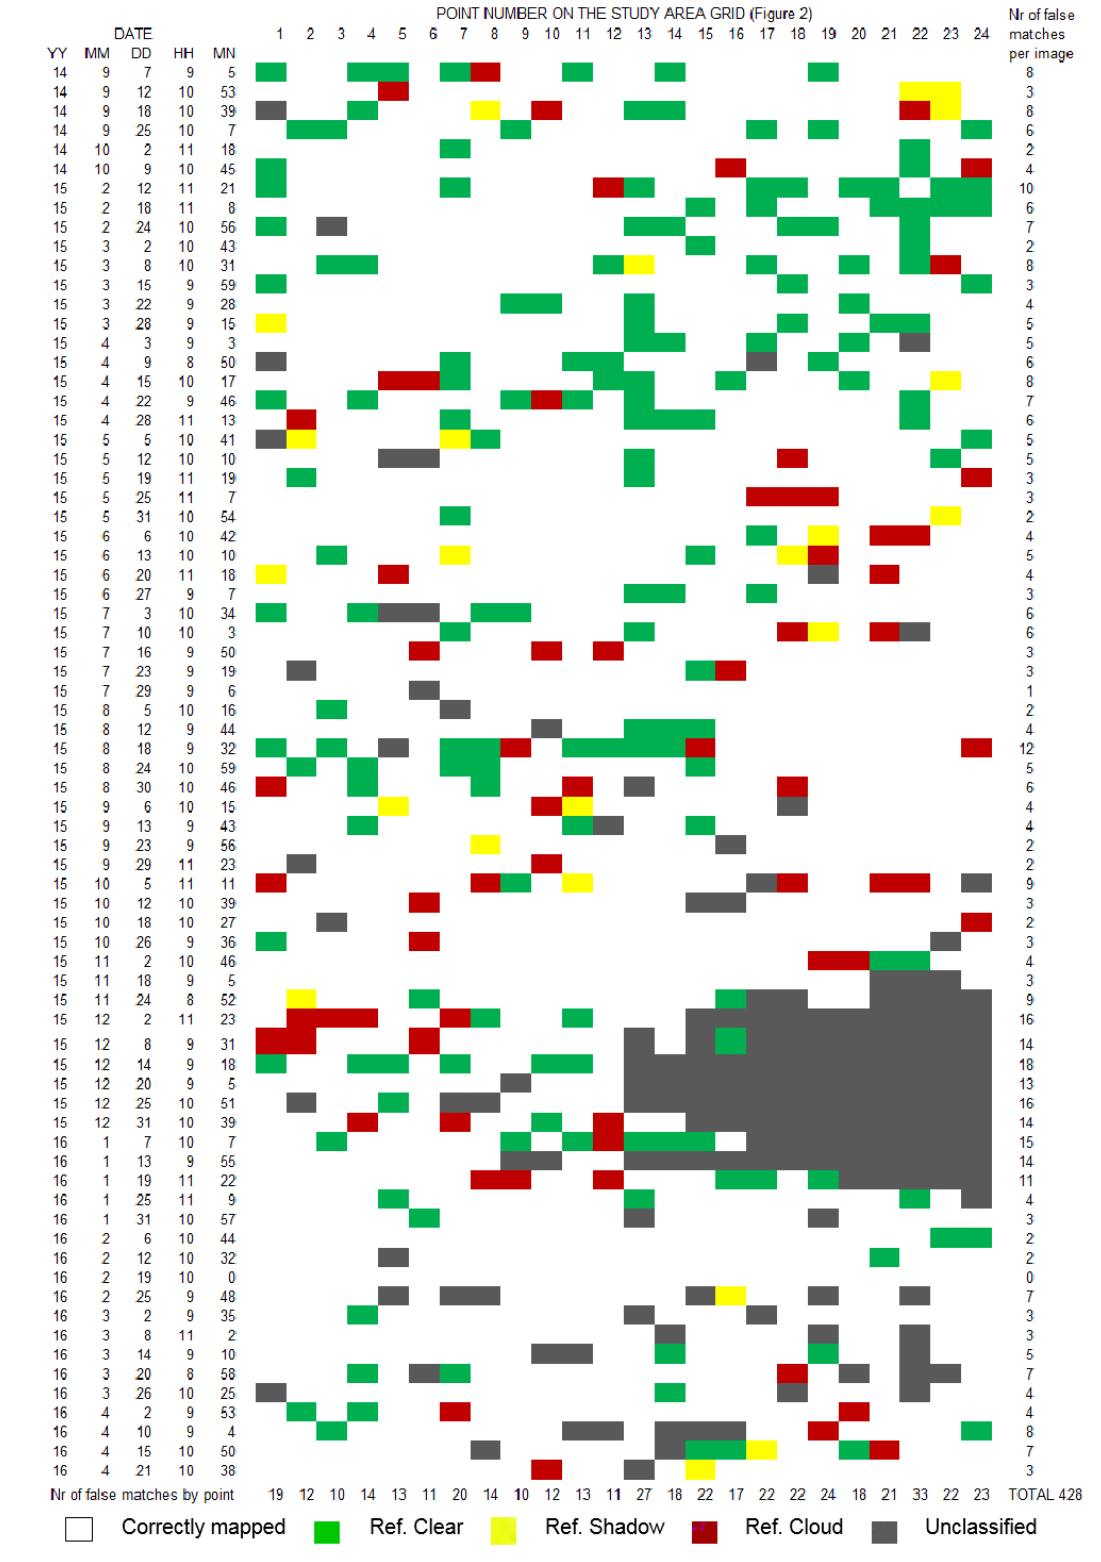
Figure 7. Distribution of correct and false matches by date ( y -axis) and by reference point index ( x